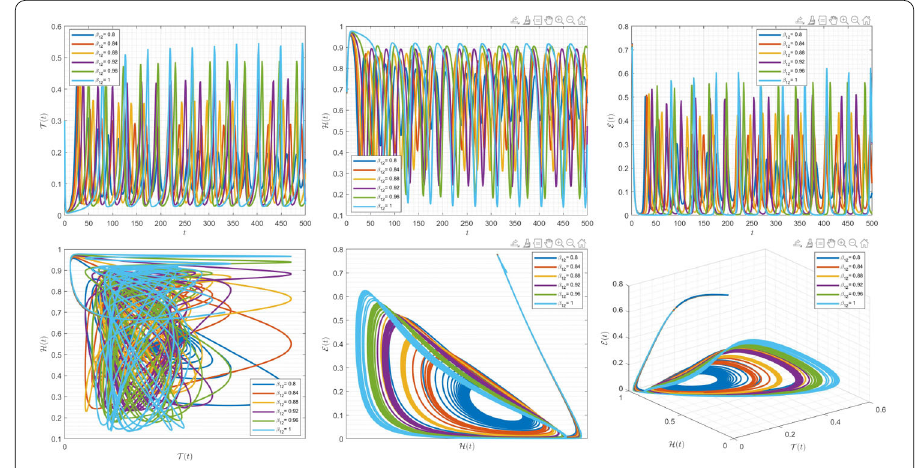
Figure 19 Simulations for solving (43) using (59) along with ( T (0), H (0), E (0)) = (0.3,0.7,0.7) and α = 0.98 for different β 12